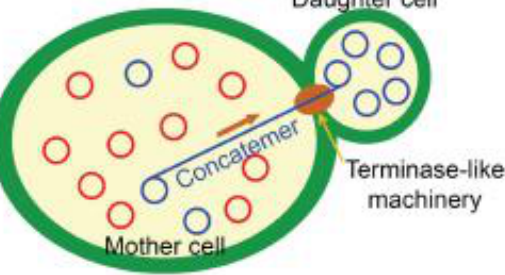
Figure 3 . Mechanism for the efficient segregation of heteroplasmic cells in the yeast, S. cerevisiae . In the heteroplasmic mother cell, a randomly selected template circular DNA molecule (a blue circle in “Mother cell”) is replicated in a rolling circle mode to produce concatemers. The concatemers are selectively transmitted to daughter cells by a mechanism resembling that of terminases, which are ATP-dependent motor proteins that package a single phage genome unit from the phage DNA concatemers into the phage capsid [54]. Upon transmission into the daughter cells, the concatemers are processed into circular monomers (blue circles in “Daughter cell”), as in the case of phage DNA packaging [12] and constitute homoplasmic